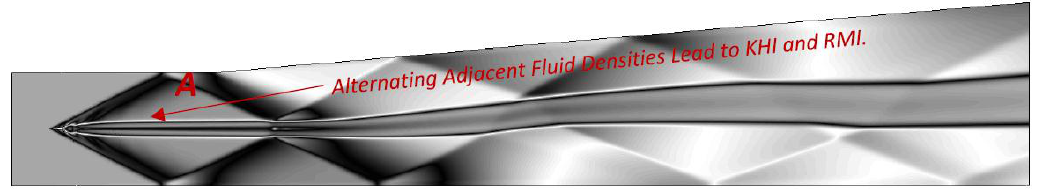
Figure 24. Shock train visualization for a single strut combustor in terms of density (kg/m 3 ).